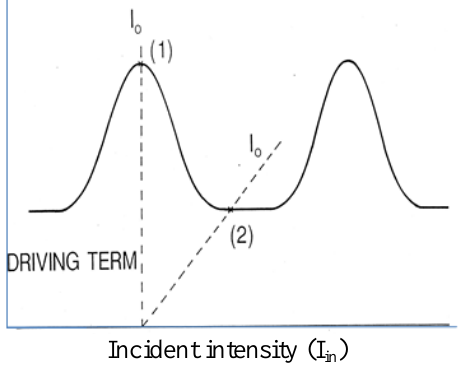
Fig.2: The dependence of the driving term on the incident intensity I